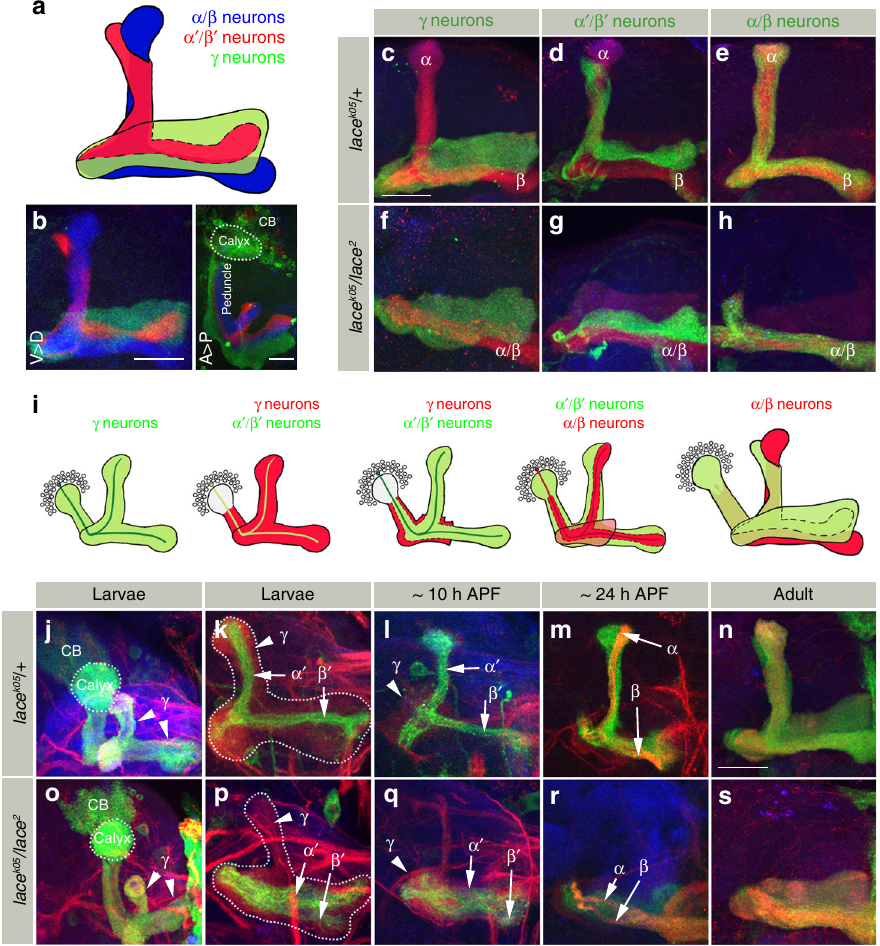
Fig. 2 Neuron class-speci fi c role of sphingolipids in MB development. a Schematic showing the three classes of MB neurons. Green: γ , Red: α ′ / β ′ and Blue: α / β . b Anterior View (Ventral (V) > Dorsal (D)) and Dorsal view (Anterior (A) > Posterior (P)) of the three differently labeled classes of MB neurons. γ : mCD8::GFP, α ′ / β ′ : mCherry, α / β : anti-FasII. Genotype: R26E01-LexA/LexAop myr::cherry; R16A06-Gal4/UAS-mCD8::GFP . R26E01-lexA ( α ′ / β ′ neurons), R16A06-Gal4 ( γ neurons). c – h Morphology of MB in lace k05 / + ( c , d , e ) and lace 2 /lace k05 ( f , g , h ) class speci fi cally labeled with mCD8::GFP for γ ( c , f ), α ′ / β ′ ( d , g ), and α / β ( e , h ) neurons. α ′ / β ′ and α / β neurons show a loss of the vertical axonal lobe in SPT mutants. n ( c ) = 26, n ( d ) = 26, n ( e ) = 38, n ( f ) = 42, n ( g ) = 36, n ( h ) = 36. i – s Schematic showing the development of different MB neuron classes ( i ). MB morphology in lace k05 / + ( j – n ) and lace 2 /lace k05 ( o – s ) at indicated developmental stages. Initially, γ neurons develop normally in SPT mutants (( j , o ) Green). The axonal morphology defects fi rst appear in α ′ / β ′ neurons (( k , p ) and ( l , q ) Green: α ′ / β ′ , Red: γ ) followed by α / β neurons (( m , r ) Green: α ′ / β ′ , Strong Red (FasII): α / β ). MB are labeled with mCD8::GFP expressed using different Gal4s: 201Y- (( j , o ) γ neurons), R30F11- (( k – m and p – r ) α ′ / β ′ and early born α / β ) and OK107-Gal4 (( n , s ) all classes of MB).